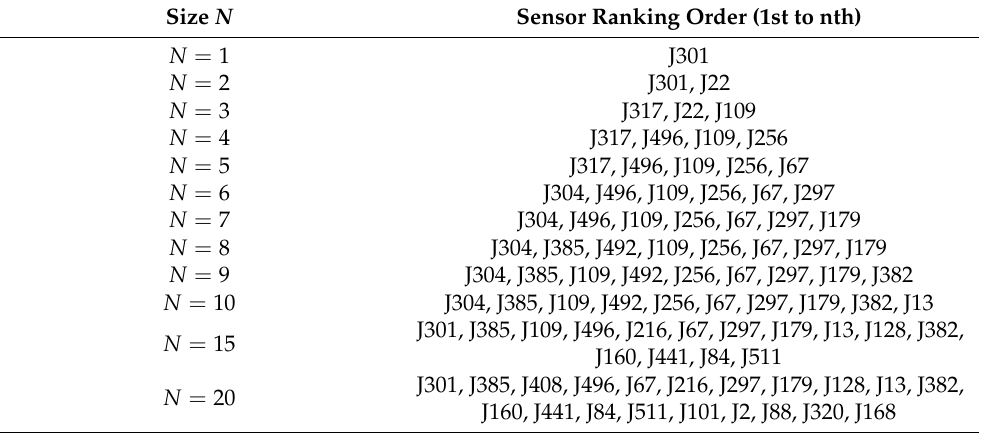
Table 1. Sensor designs of size N and the sensor ranking of the